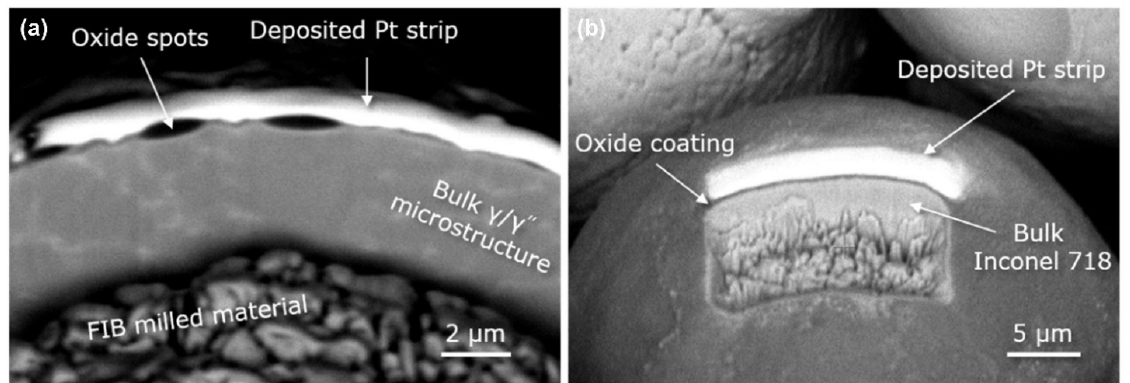
Figure 18. Back-scattered electron micrograph of particle with FIB sectioning to reveal microstructure and surface oxides (darker material) for particle ( a ) with oxide spots and ( b ) with oxide coating. The bright section is the sacrificial platinum strip deposited prior to ion milling. (Reprinted with permission from Ref. [66]. Copyright 2018 Elsevier B.V.).